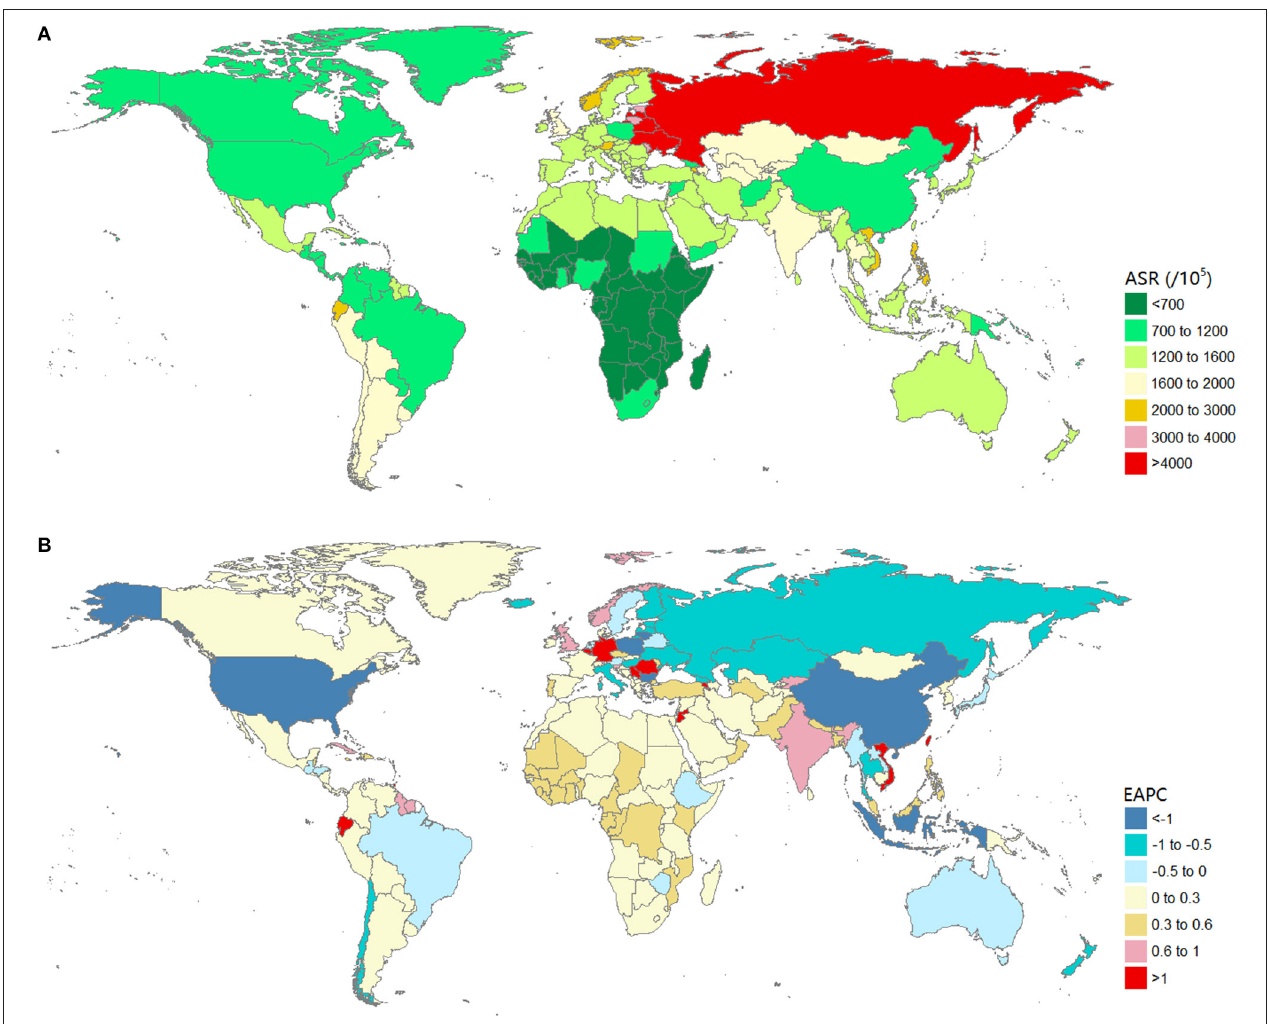
FIGURE 3 | The global burden of urolithiasis in 204 countries or territories. (A) The age-standardized incidence rate of urolithiasis in 2019. (B) The EAPC of age-standardized prevalence rate of urolithiasis from 1990 to 2019. Countries with an extreme number of cases/evolution were annotated. EAPC, estimated annual percentage